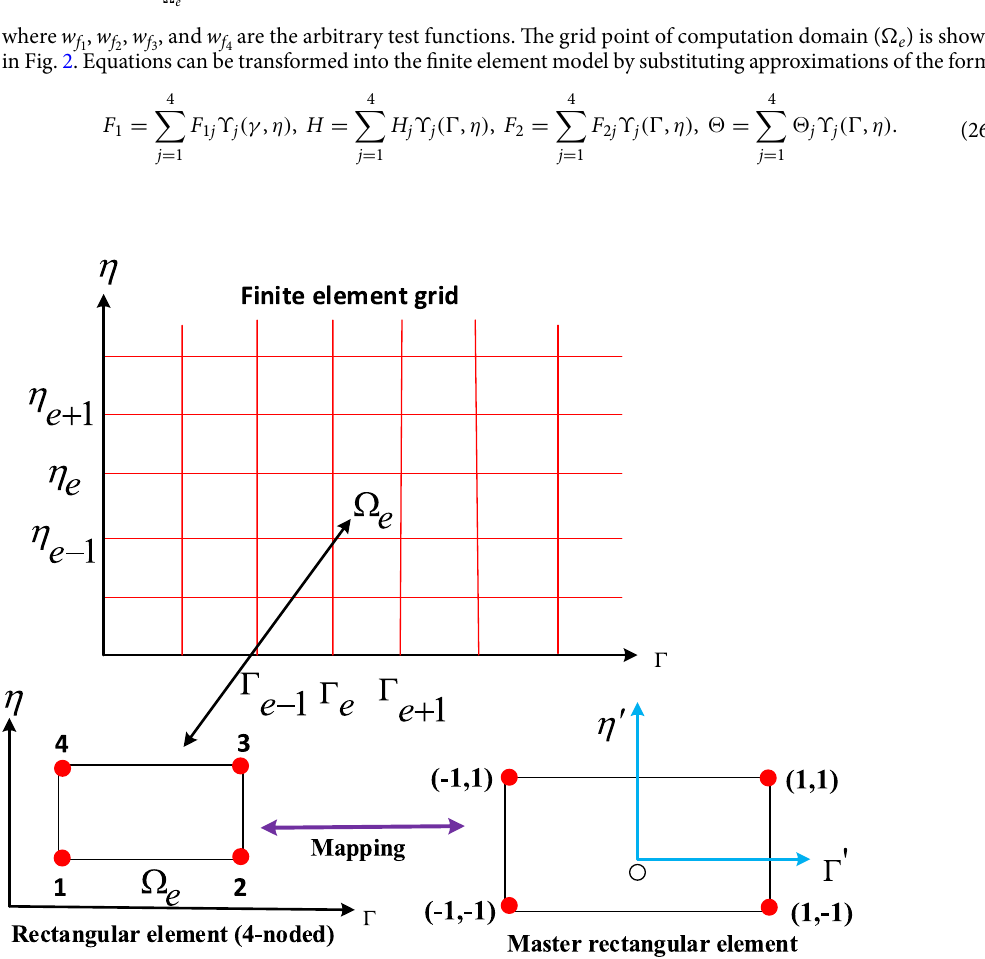
Figure 2. Finite element grid and